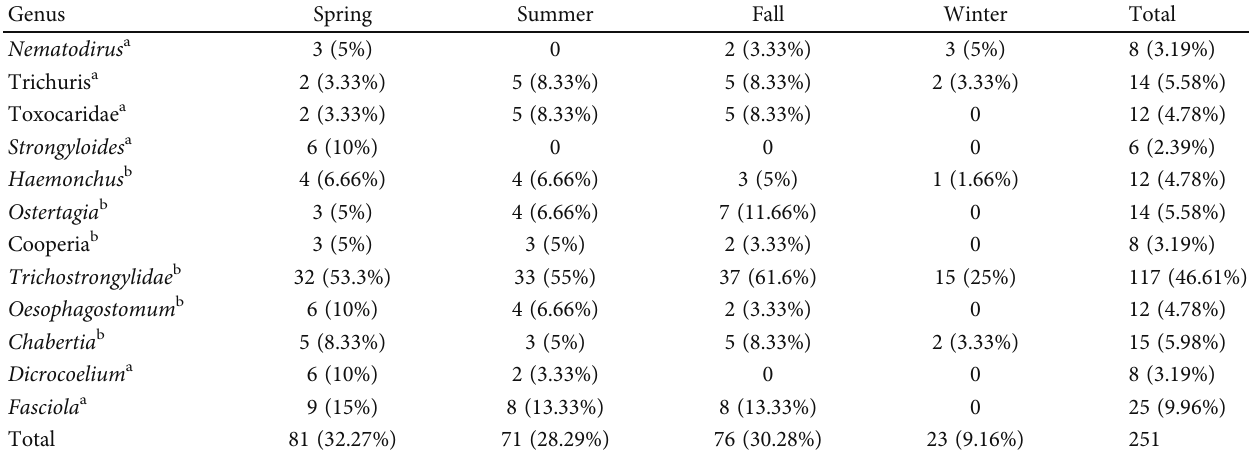
Table 1: The number (percentage) of the observed gastrointestinal